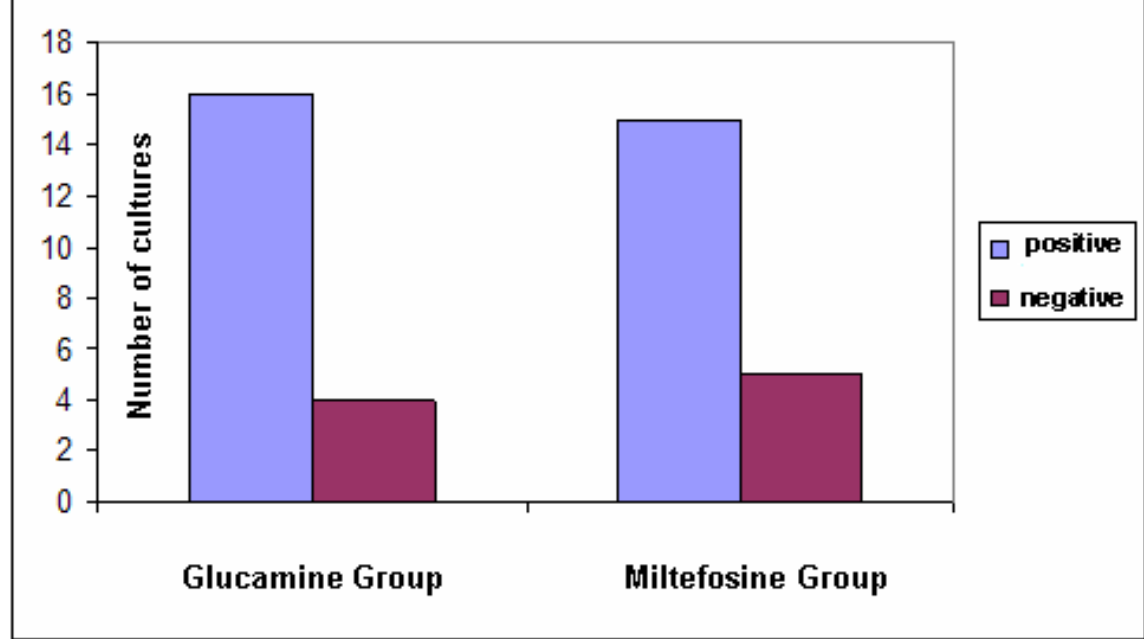
Figure 2. Positive or negative Leishmania amastigote forms in cultures from mice treated with N-methyl glucamine only (Glucamine Group) and with N-methyl glucamine plus topical miltefosine (Miltefosine Group) after treatment